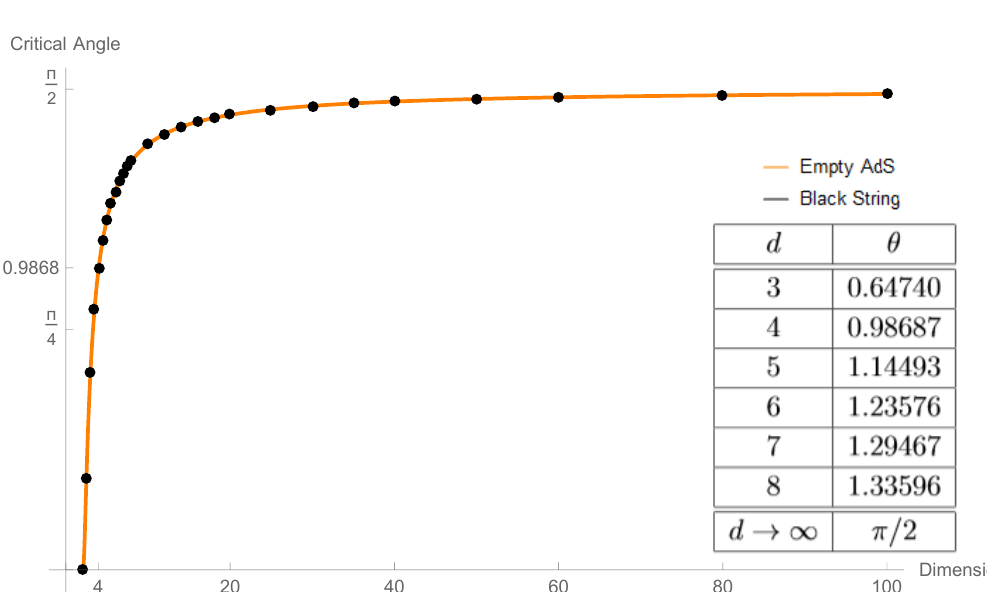
Figure 8: The critical angles in AdS for various dimensions d > 2, analytically d + 1 continued to real values. The critical angle vanishes at precisely d = 2. Both empty AdS and the black string feature the same critical angles; the orange curve was ob- tained using (59), and the black points were obtained numerically by solving the shooting problem for the black string. The reason for the equivalence is that black string island surfaces near the critical angle are located near the defect, where the metric is well approximated by empty